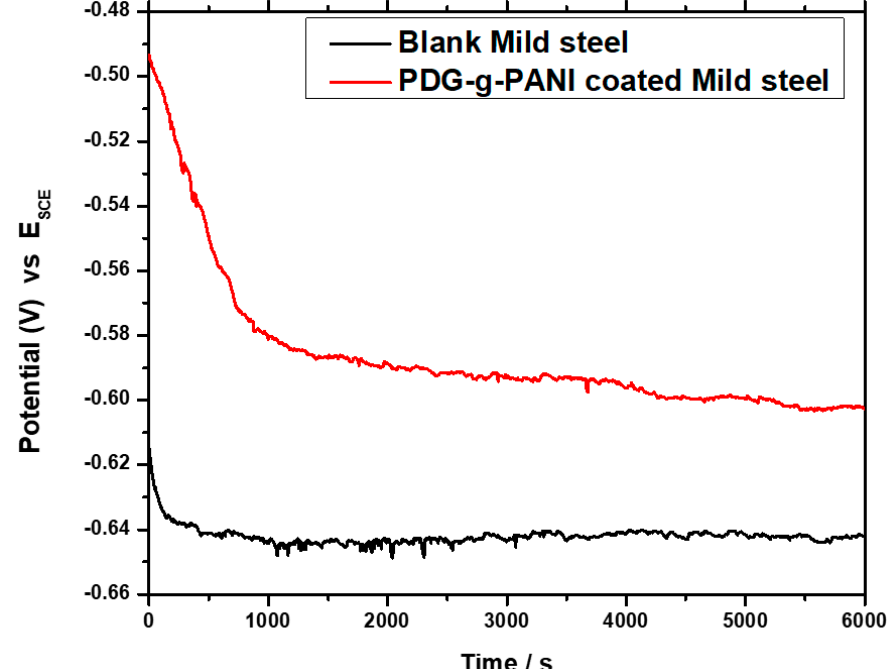
Figure 7. Open circuit potential of uncoated and PDG-g-PANI-coated MS.